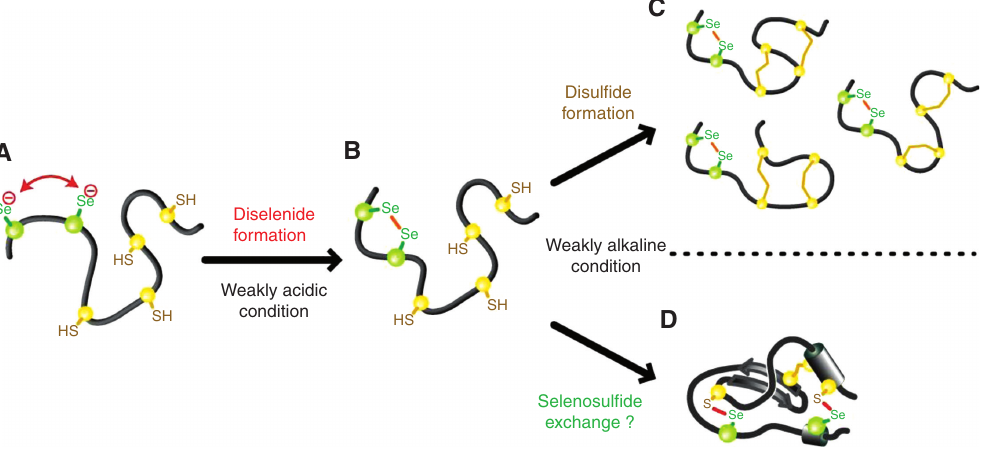
Figure 2 Regulation of disulfide-coupled peptide and protein folding using a diselenide bond. (A) A diselenide bond can be regioselectively formed in SeCys-containing peptides or proteins in an aqueous buffer under weakly acidic conditions. (B) The protein with a diselenide bond and free thiol groups can be trapped and purified because the diselenide bond is gener- ally resistant for thiol groups. (C) Disulfide bond formation occurs between Cys residues under weakly alkaline conditions without the diselenide-disulfide exchange reaction, providing the native or non-native disulfide proteins. (D) The net stability of proteins may overcome the partial stability of diselenide bonds. SeCys-containing BPTI was able to fold into the native conformation via the mis-bridged SeCys 5 - SeCys 14 folding